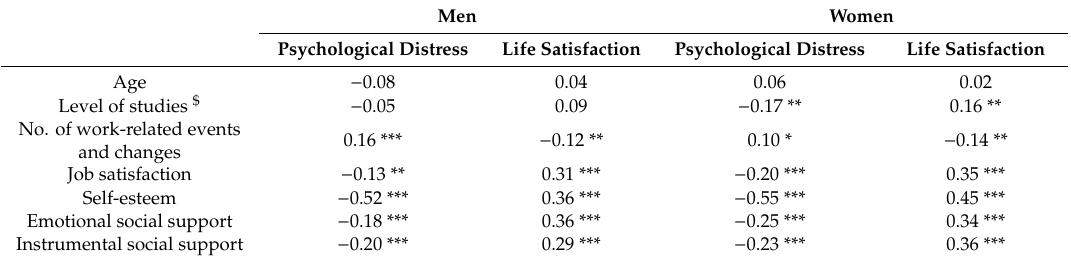
Table 1. Correlations between the dependent and independent variables amongst men and women. Men